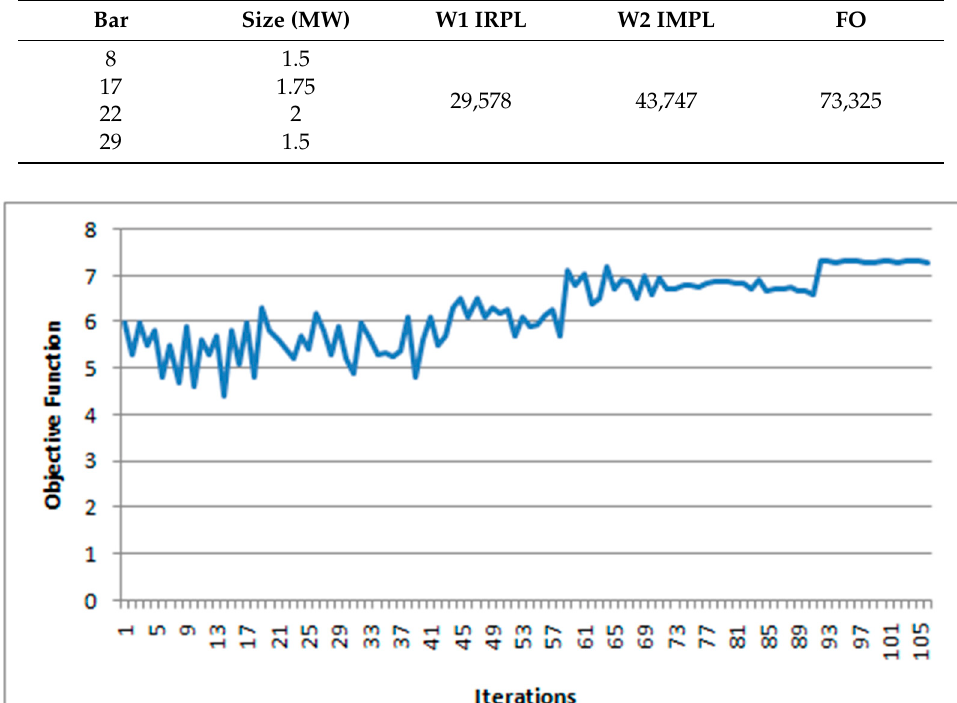
Figure 6. Convergence process in SA.